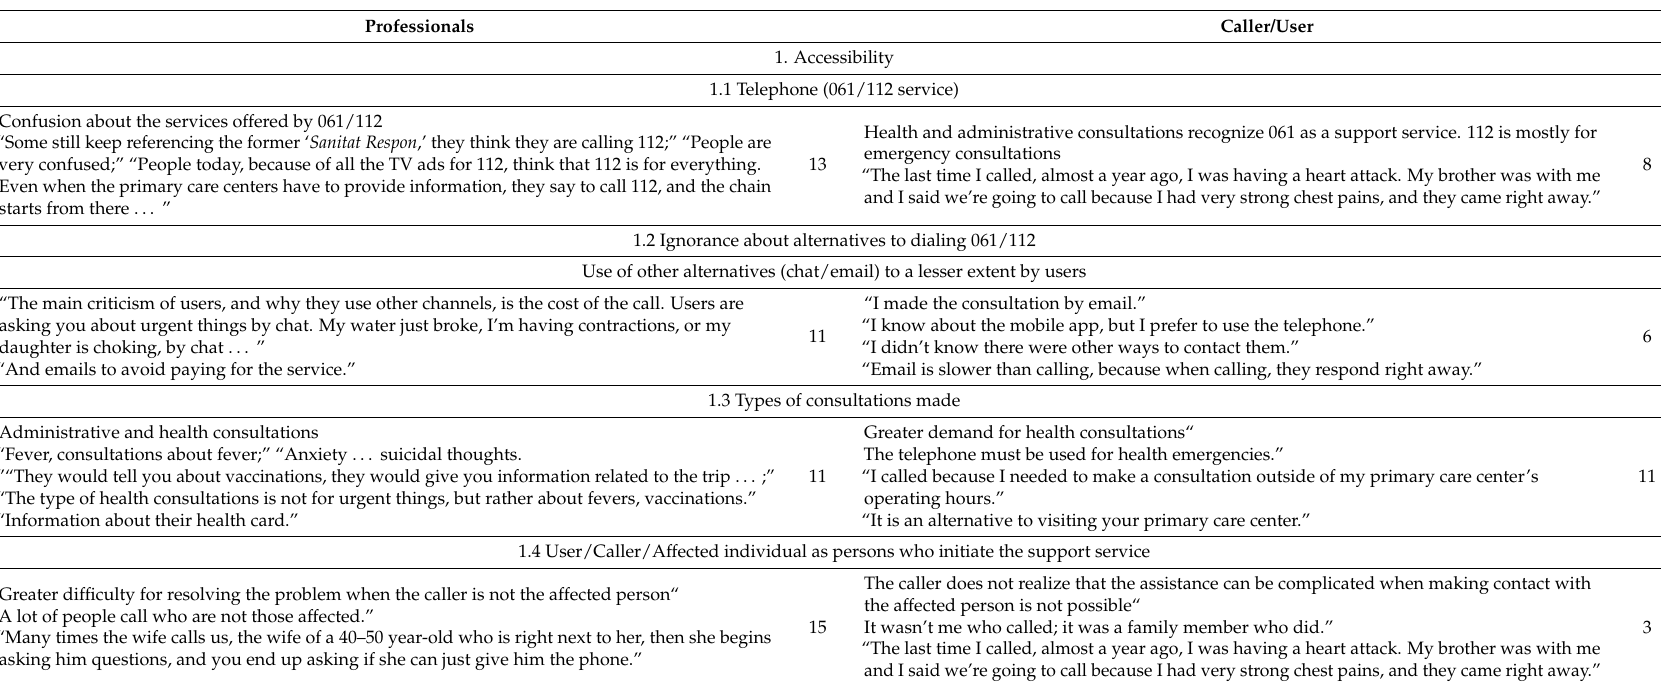
Table 2. Subprocess 1: Service